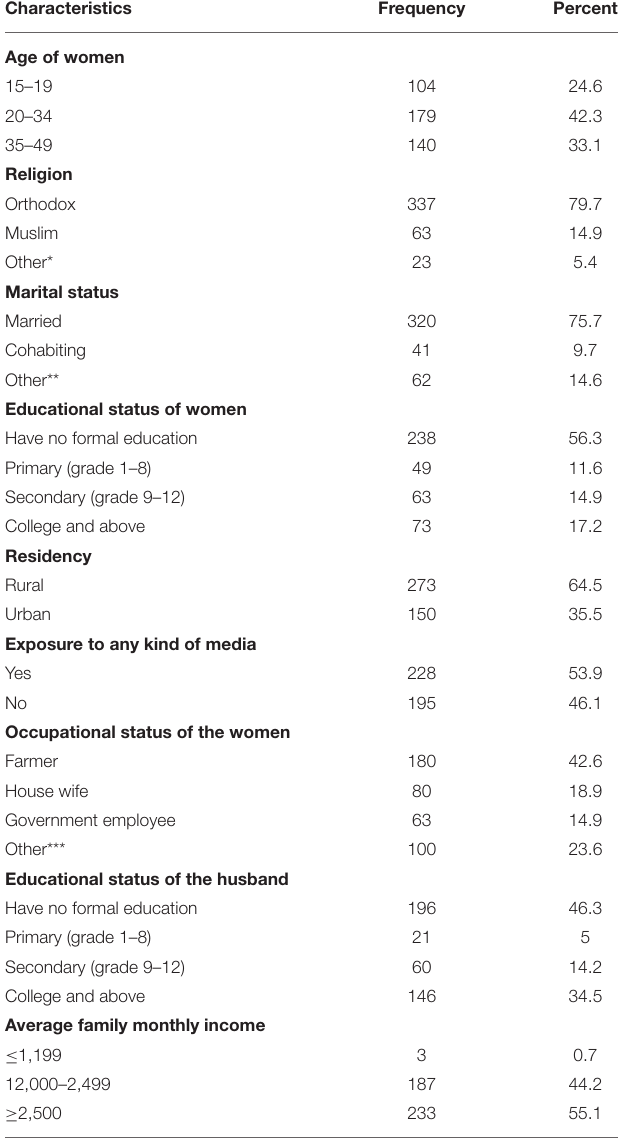
TABLE 1 | Sociodemographic characteristics of women in Debremarkos city, northwest Ethiopia. Characteristics